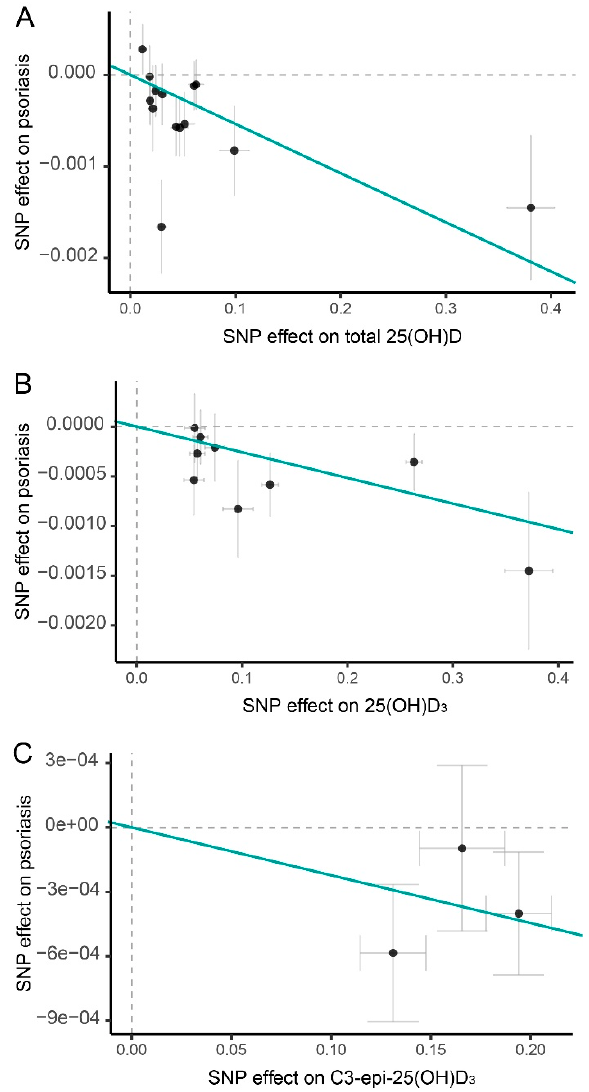
Figure 2. Scatter plots of genetic effects of IVs on vitamin D levels and the risk of psoriasis. The genetic effects of IVs on ( A ) 25(OH)D levels, ( B ) 25(OH)D 3 , ( C ) C3-epi-25(OH)D 3 and the risk of psoriasis. The x -axis denotes genetic effects of instruments variables (IVs) on exposure while the y -axis depicts the genetic effects of IVs on outcome. The slope of the solid line represents the causal estimation in inverse-variance weighted methods of MR analyses. The vertical and horizontal dashed lines denote genetic effect β = 0 for exposure and outcome, respectively. The gray bar depicts the standard error for each genetic effect estimation. Abbreviations: 25(OH)D: 25-hydroxyvitamin D; 25(OH)D 3 : 25-hydroxyvitamin D 3 ; C3-epi-25(OH)D 3 : C3-epimer of 25-hydroxyvitamin D 3 ; SNP: single nucleotide polymorphism .